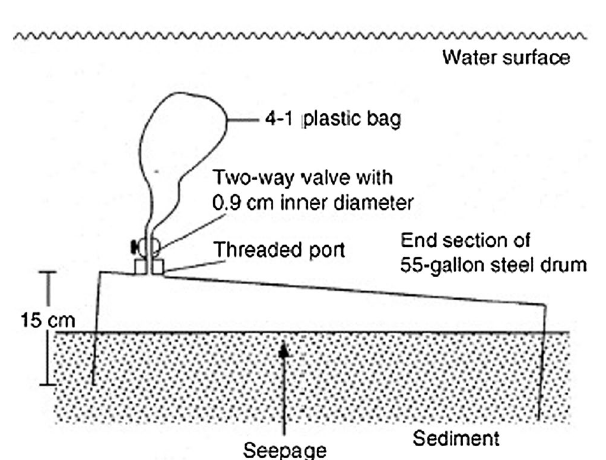
Fig. 3 Lee type seepage meter (Lee